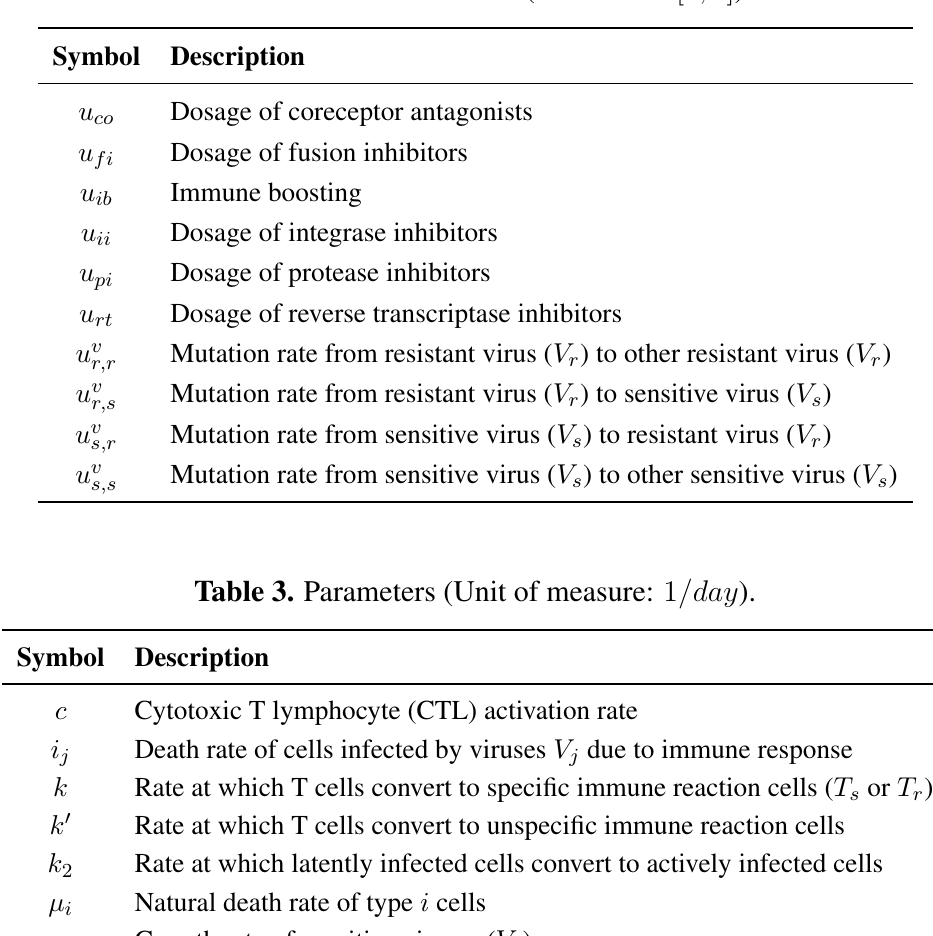
Table 2. Control functions (bounded in [0 , 1] ).